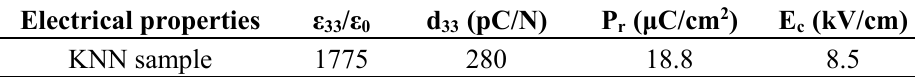
Figure 7. The hysteresis loop of the sintered KNN sample. Table 1. Dielectric and piezoelectric properties of the sintered KNN